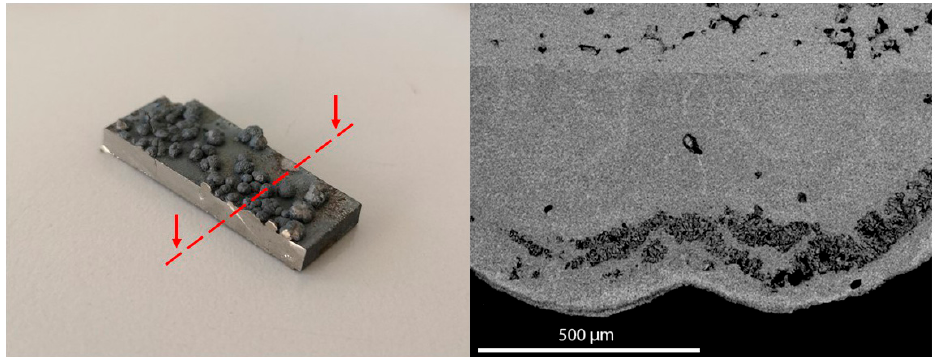
Figure 2. Picture of the 900C5h sample with an indication of the observed section and SEM micro- graph representing the section of the segregation region.